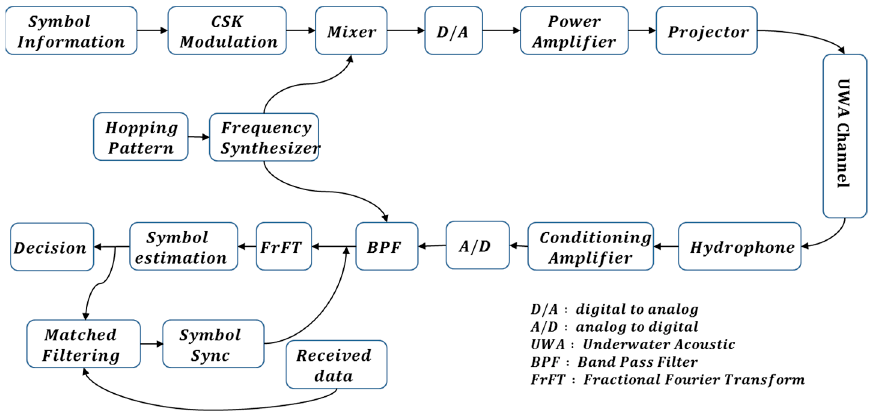
Figure 2. Block diagram of the proposed method .